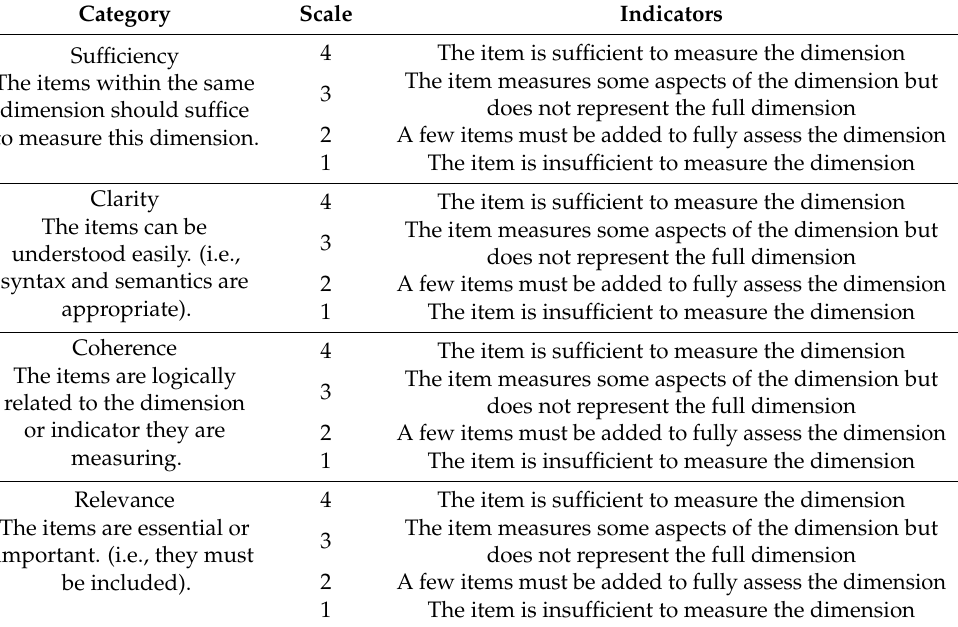
Table 3. Categories, indicators, and scale.